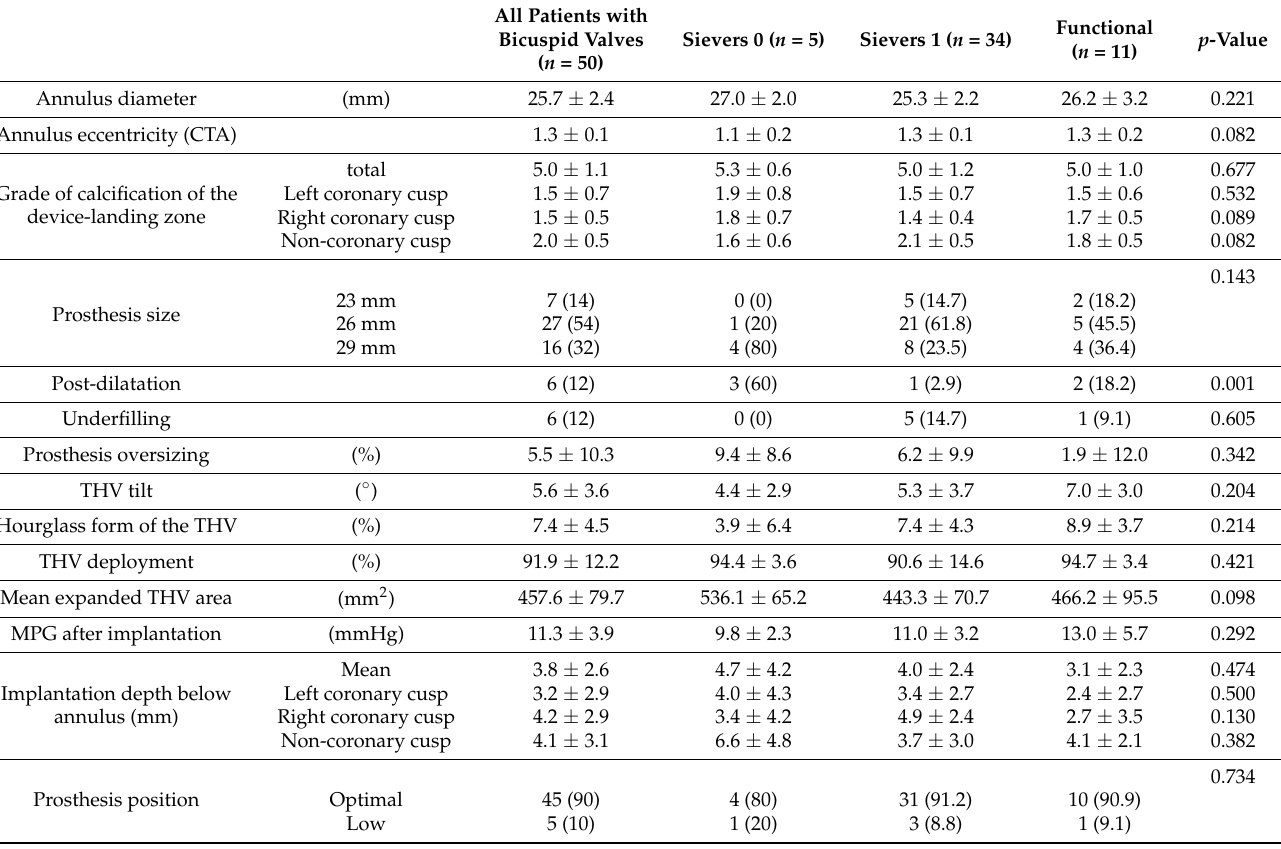
Table 2. Baseline, procedural, and THV position characteristics of the entire patient population with bicuspid aortic valves and for individual BAV